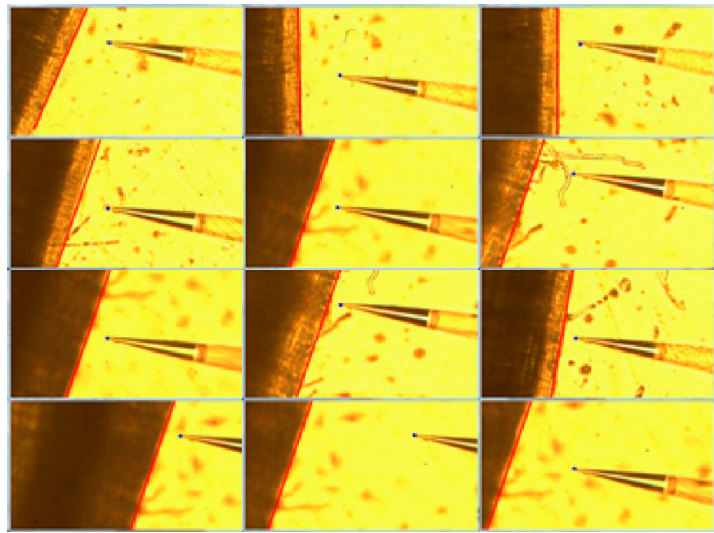
Figure 19. Tip of ISME and root identification.